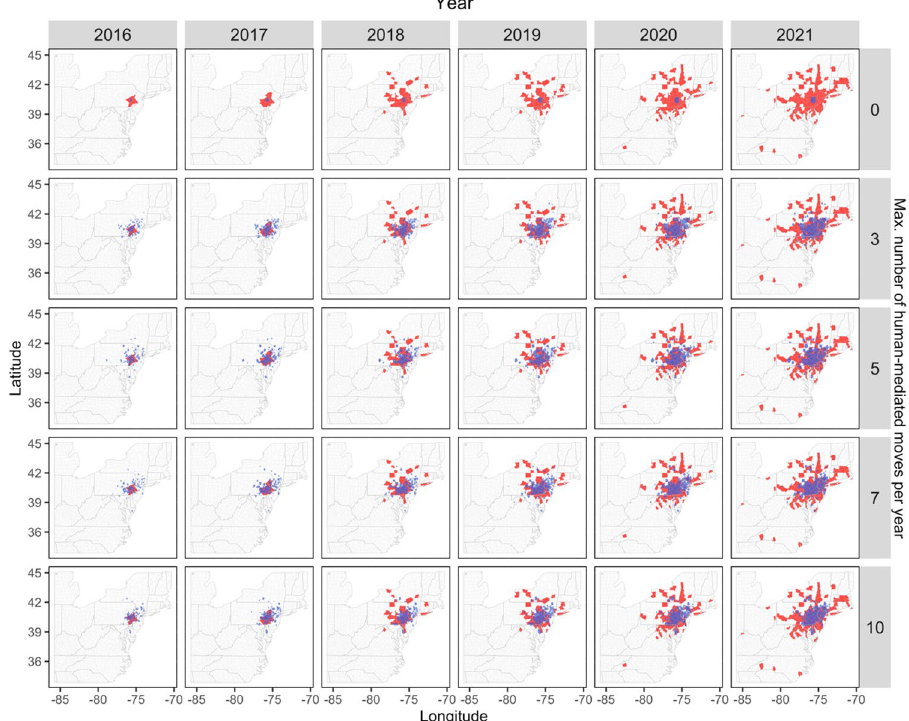
Figure 7. Maps showing observed spotted lanternfly occurrence by year (red polygons) between 2016 and 2021 and model-predicted cells (blue) where spotted lanternflies were predicted to occur with ≥ 0.95 probability. Model-predicted estimates were obtained from the scenario with an intrinsic growth rate of 1.5 and where the movement type of individuals was non-random. Compared are the model scenarios with varying maximum number of human-mediated movements per year including 0, 3, 5, 7, and 10. The small multiple maps were produced using the ‘ggplot2’ (ver. 3.3.6; https:// cran.r- proje ct. org/ web/ packa ges/ ggplo t2/ index. html) and ‘ggmap’ (ver. 3.0.0.903; ver. 3.0.0.903; https:// cran.r- proje ct. org/ web/ packa ges/ ggmap/ index. html) packages in